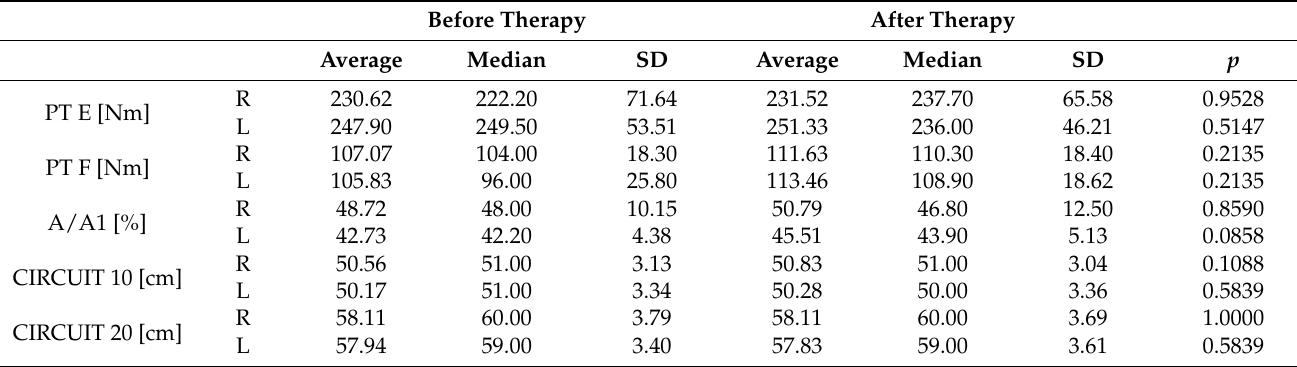
Table 3. Descriptive statistics and the statistical significance of the differences registered between the analysed parameters before and after therapy in the control group.